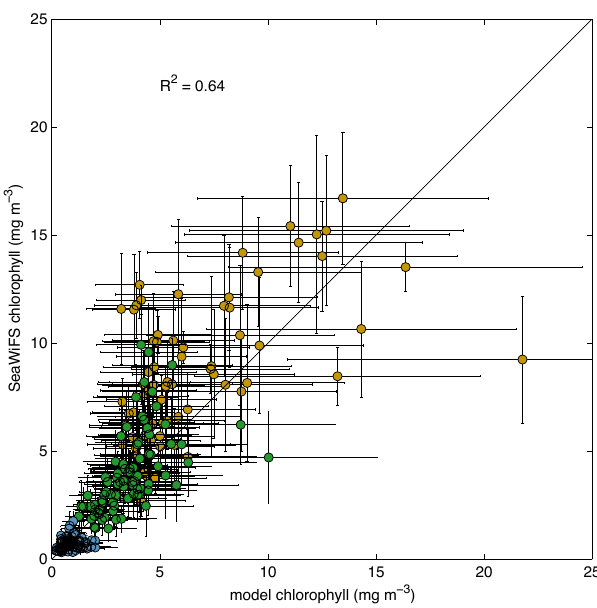
Fig. 9. Monthly mean SeaWiFS chlorophyll concentrations from January 1998 to December 2004 plotted over simulated surface chlorophyll; both averaged over the delta (brown dots), interme- diate (green dots) and far-field (blue dots) regions. Errorbars in- dicate one standard deviation. The 1-to-1 line is shown as black line. Coefficient of determination, defined as R 2 = 1 − SS err the total sum of squares SS tot = P i (o i − ¯ o) 2 , the residual sum of squares SS err = P i (m i − o i ) 2 , monthly mean observed values o i , and monthly mean model values m i , is